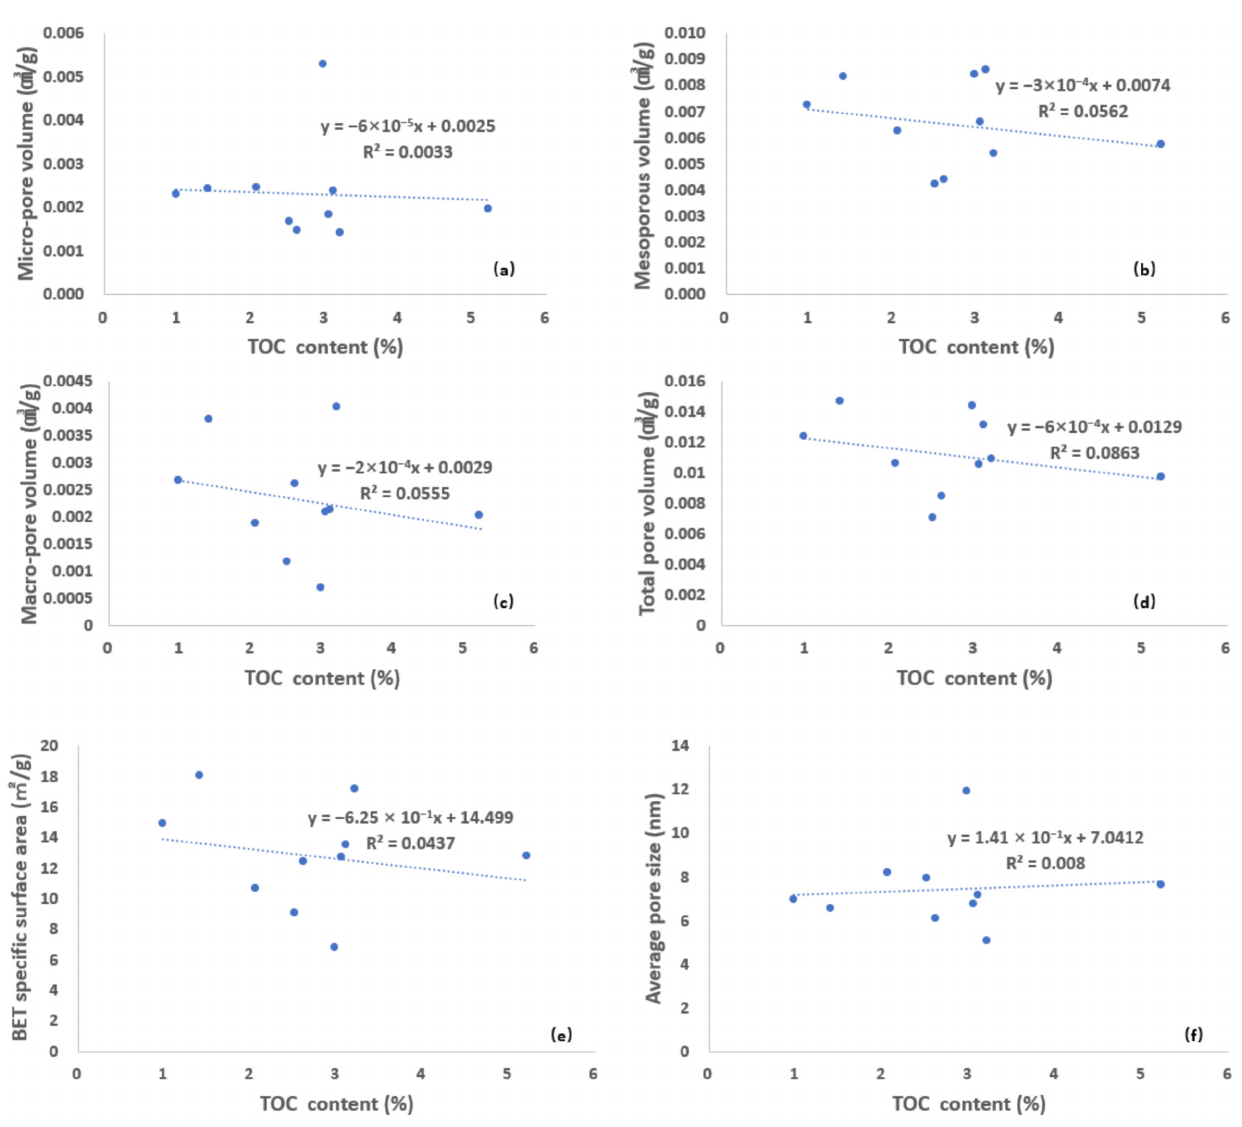
Figure 7. Relationship between microscopic pores and TOC content of lower Cambrian black shale from the Niutitang formation in Wenshuicun, Guizhou province; ( a ) the cross plot of micropore volume and the TOC content; ( b ) the cross plot of mesopore volume and the TOC content; ( c ) the cross plot of Macropore volume and the TOC content; ( d ) the cross plot of total pore volume and the TOC content; ( e ) the cross plot of BET specific surface area and the TOC content; ( f ) the cross plot of average pore size and the TOC